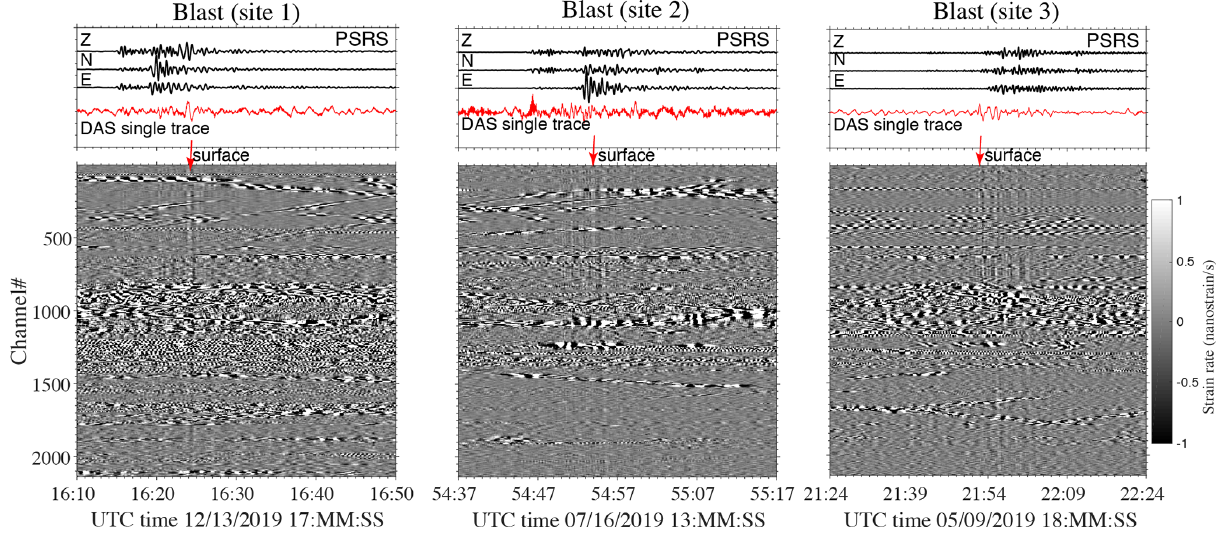
Figure 13. Seismic station (PSRS) and DAS recordings of three quarry blast signals from three mining sites (site 1, site 2 and site 3). Their magnitudes from the Pennsylvania State Seismic Network catalog are M1.3, M1.7, and M2.0, respectively. Red arrows indicate strong surface wave